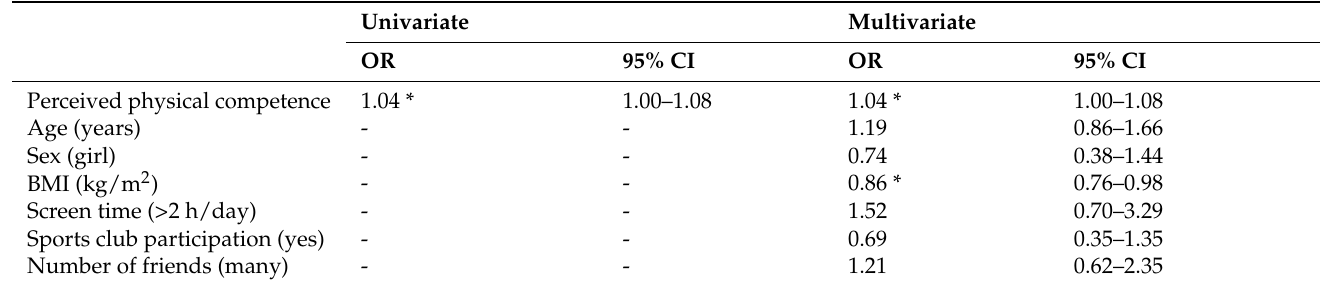
Table 2. Logistic regression analysis assessing the relationship between perceived physical compe- tence and outdoor play for all participants.